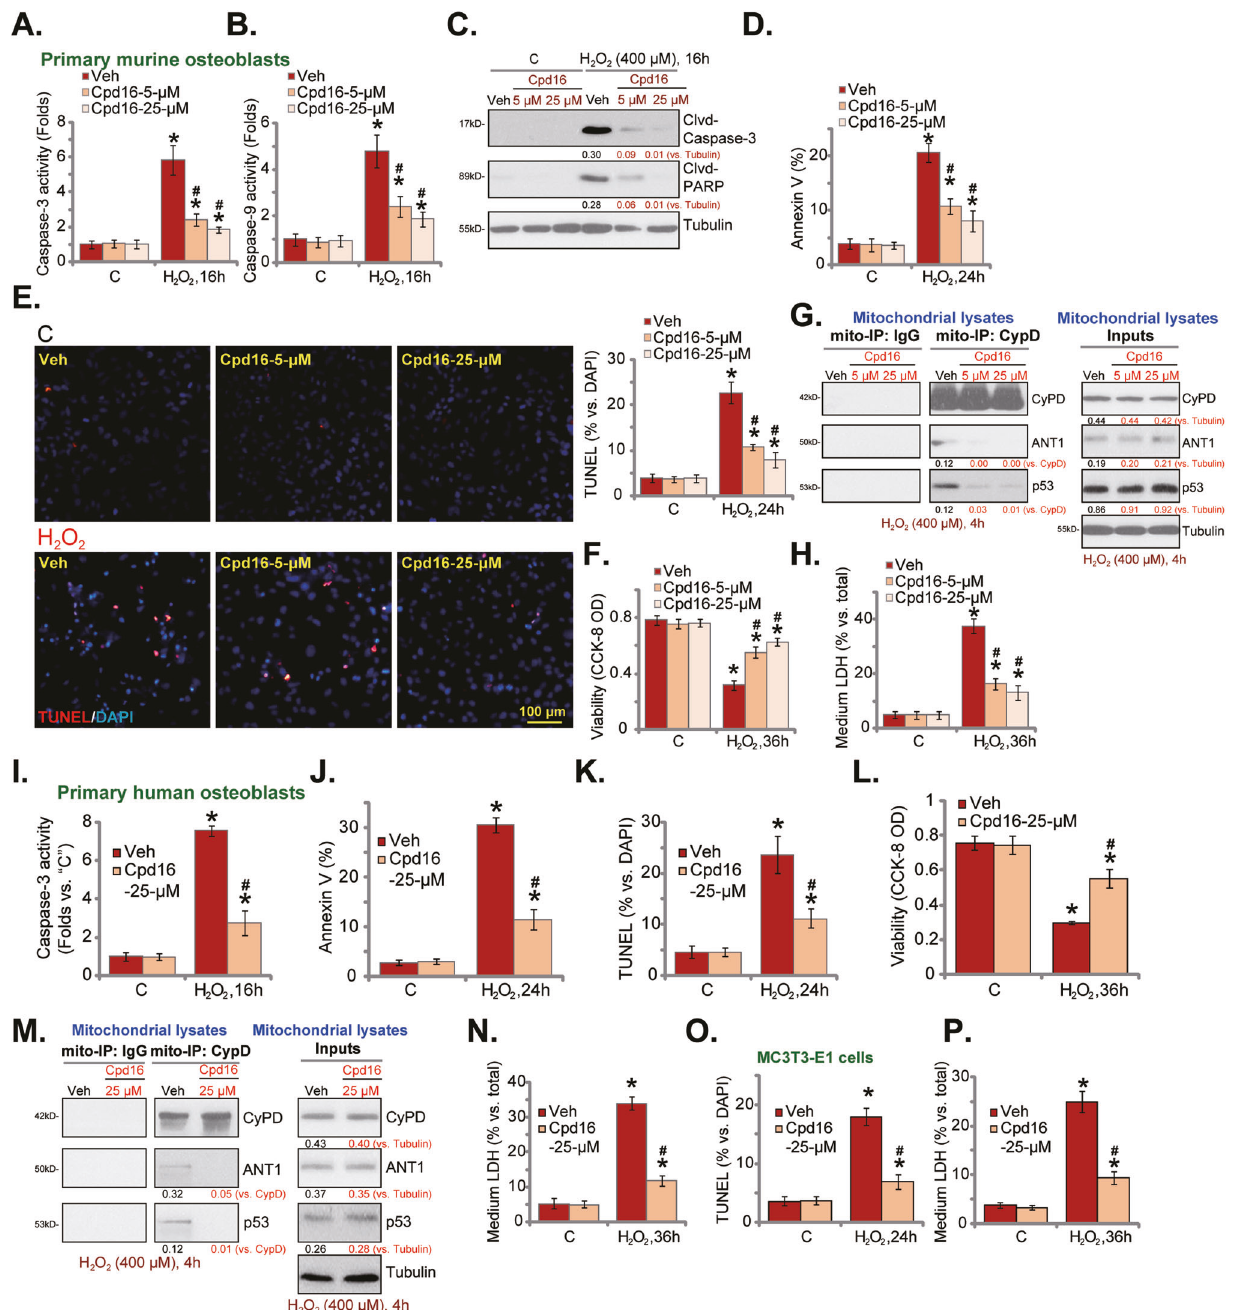
Fig. 3 Cpd16 ameliorates H 2 O 2 -induced apoptosis and programmed necrosis in osteoblasts. Primary murine osteoblasts ( A – H ), human osteoblasts ( I – N ) or the MC3T3-E1 murine osteoblastic cells ( O , P ) were pretreated (for 2 h) with Cpd16 (5/25 μ M), or plus H 2 O 2 (400 μ